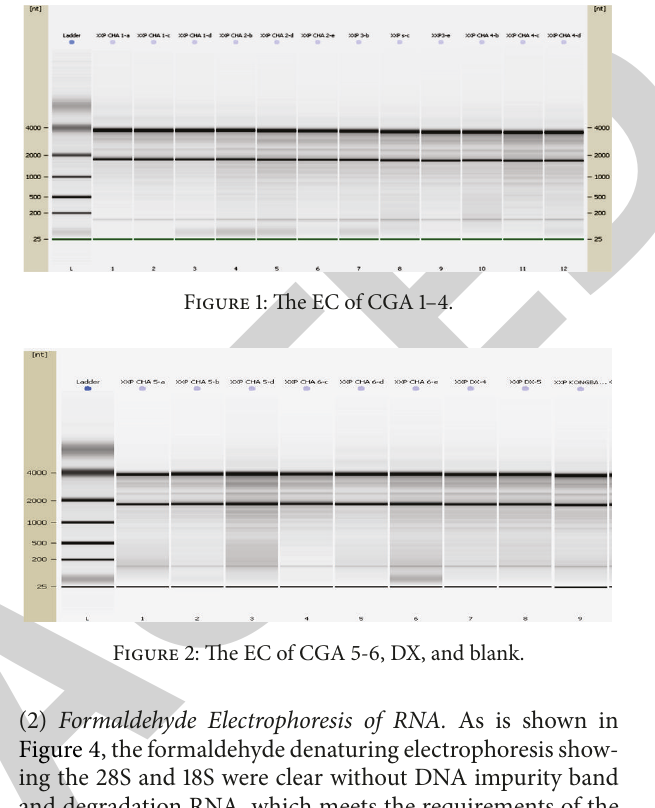
Figure 2: The EC of CGA 5-6, DX, and